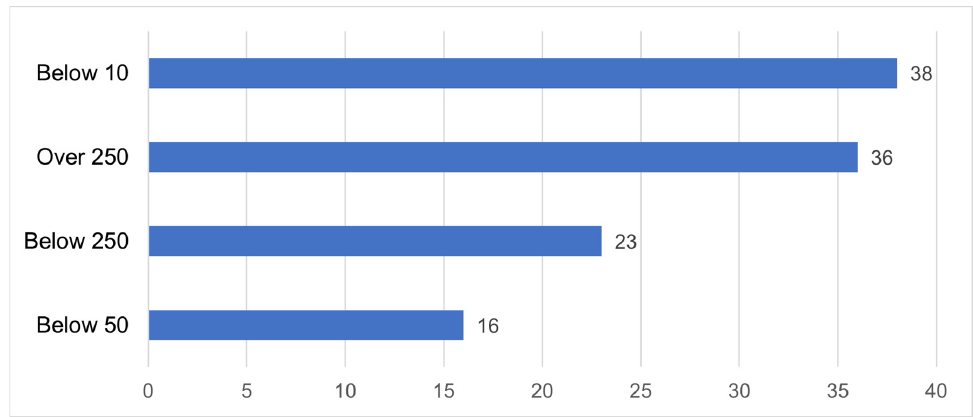
Figure 6. The number of employees.